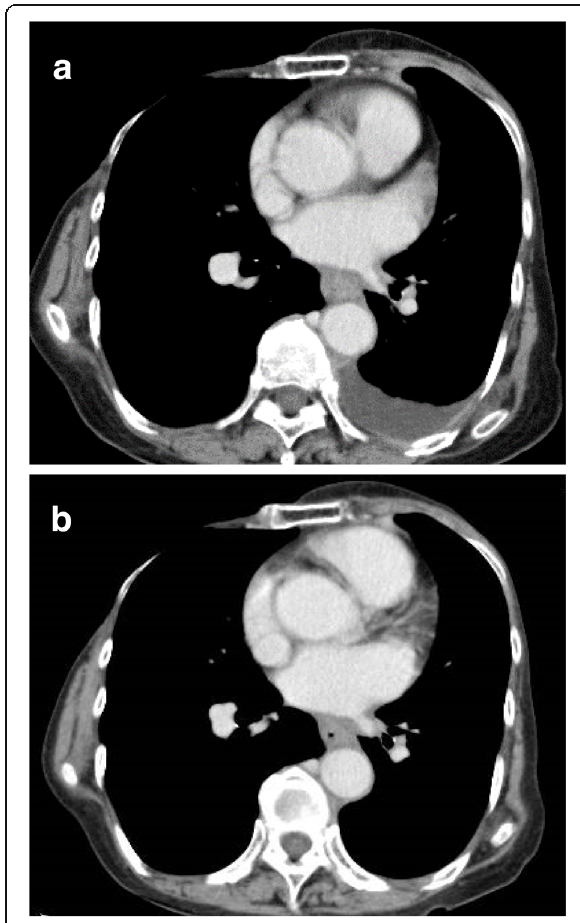
Fig. 4 Thoracic enhanced CT findings. Thoracic enhanced CT showing wall thickening of mid-esophagus and left pleural effusion ( a ). After 3 months of endocrine therapy, the pleural effusion has disappeared ( b